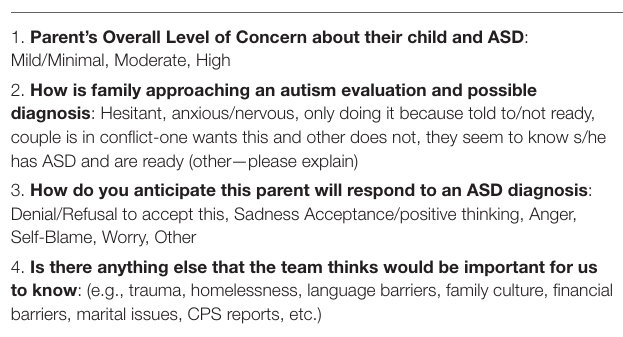
TABLE 1 | Questions about parent orientation towards diagnosis from ‘Birth-3 Team Input’ Form. Instructions: Please circle all that apply. Use additional space provided to answer each